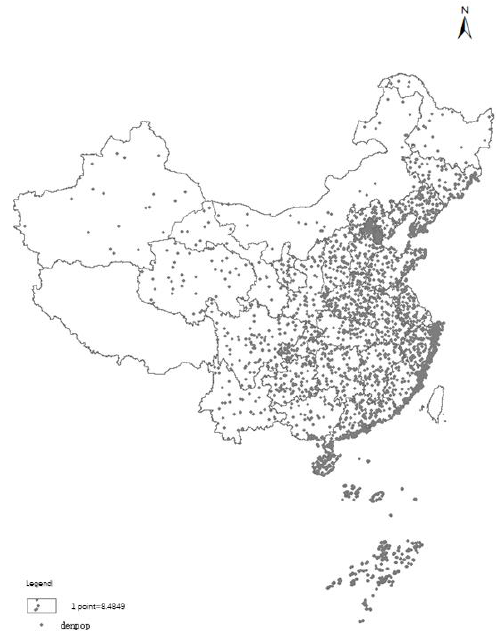
Figure 4. Spatial Distribution Map of Point Density in Chinese Population Density in 2015.Data Source: China City Statistical Yearbook 2016. https://www.tongjinianjian.com/111090.html (accessed on 20 December